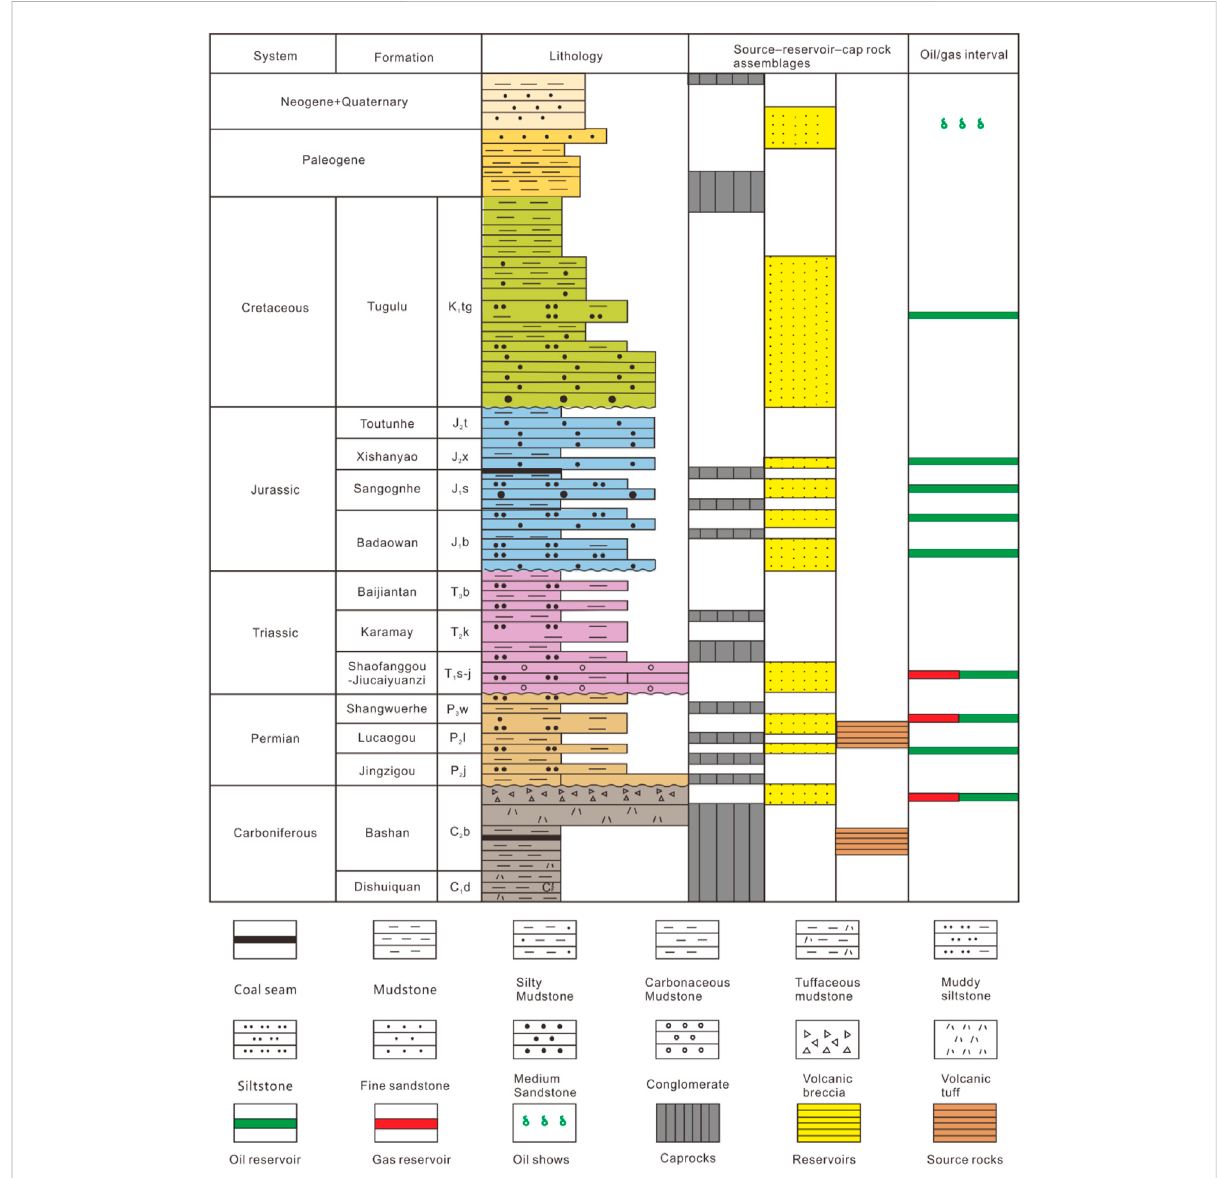
Frontiers in Earth